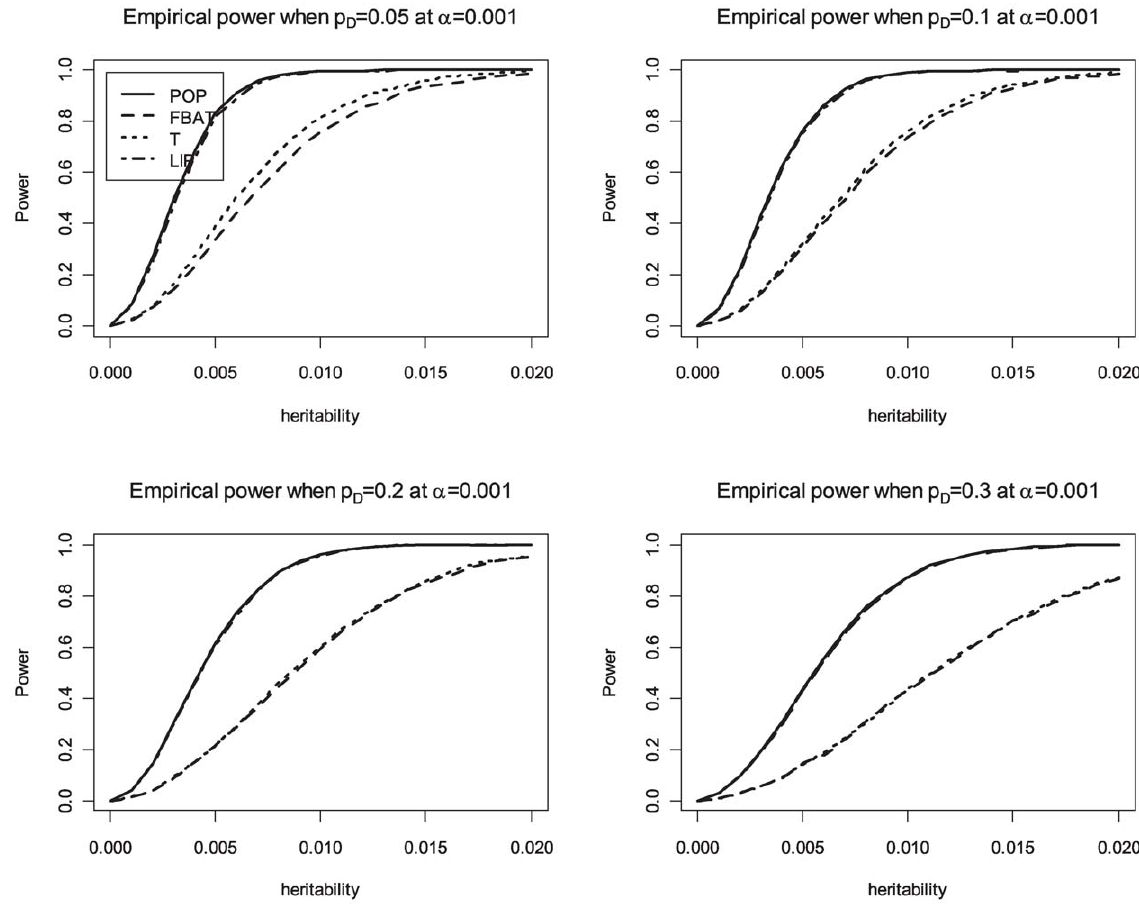
Figure 2. Empirical power at 0.001 significance level for dominant disease. POP is the empirical power of the standard population-based method. T is the empirical power of the Wald test based on the conditional mean model [22] for between-faimly components. LIP is the empirical power of the combined p-values with Liptak’s method. In this figure, FBAT and T are completely overlapped.